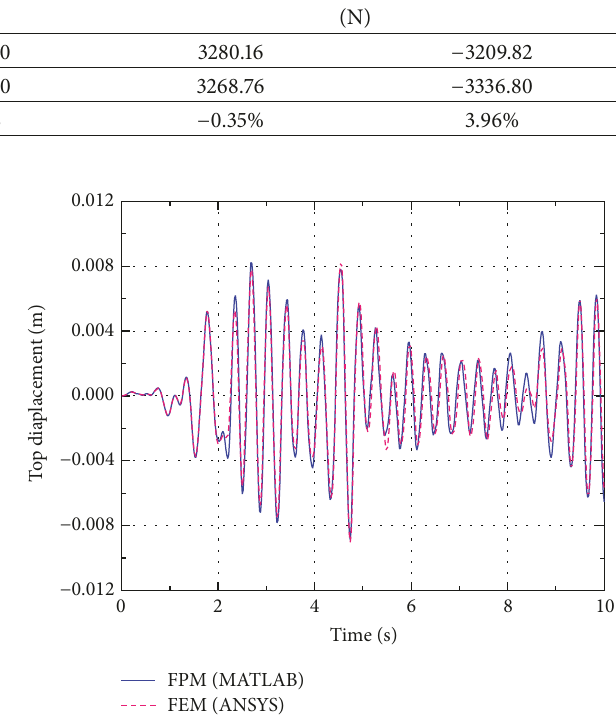
Figure 28: X-direction time history curve of